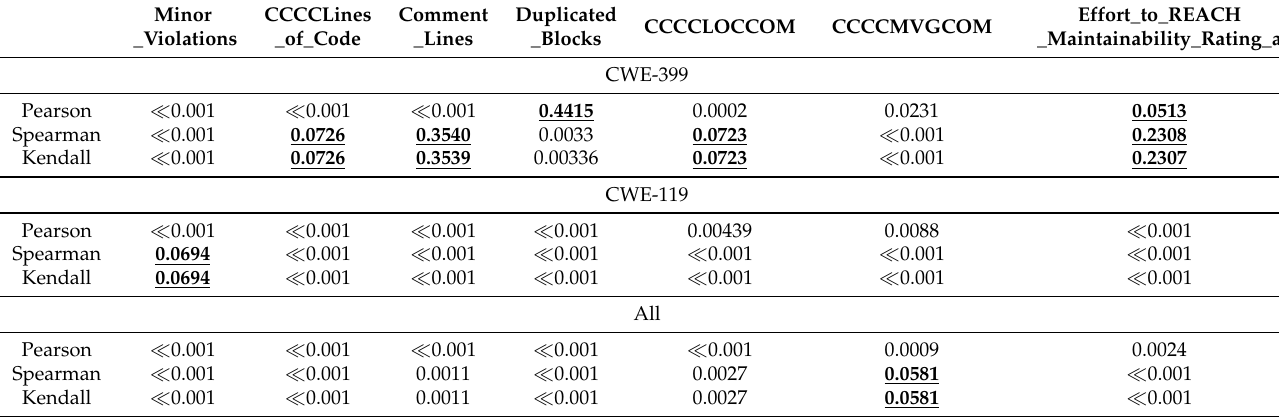
Table 2. p -values obtained in the correlation analysis for the columns, in which at least one p -value suggests that the null hypothesis should be